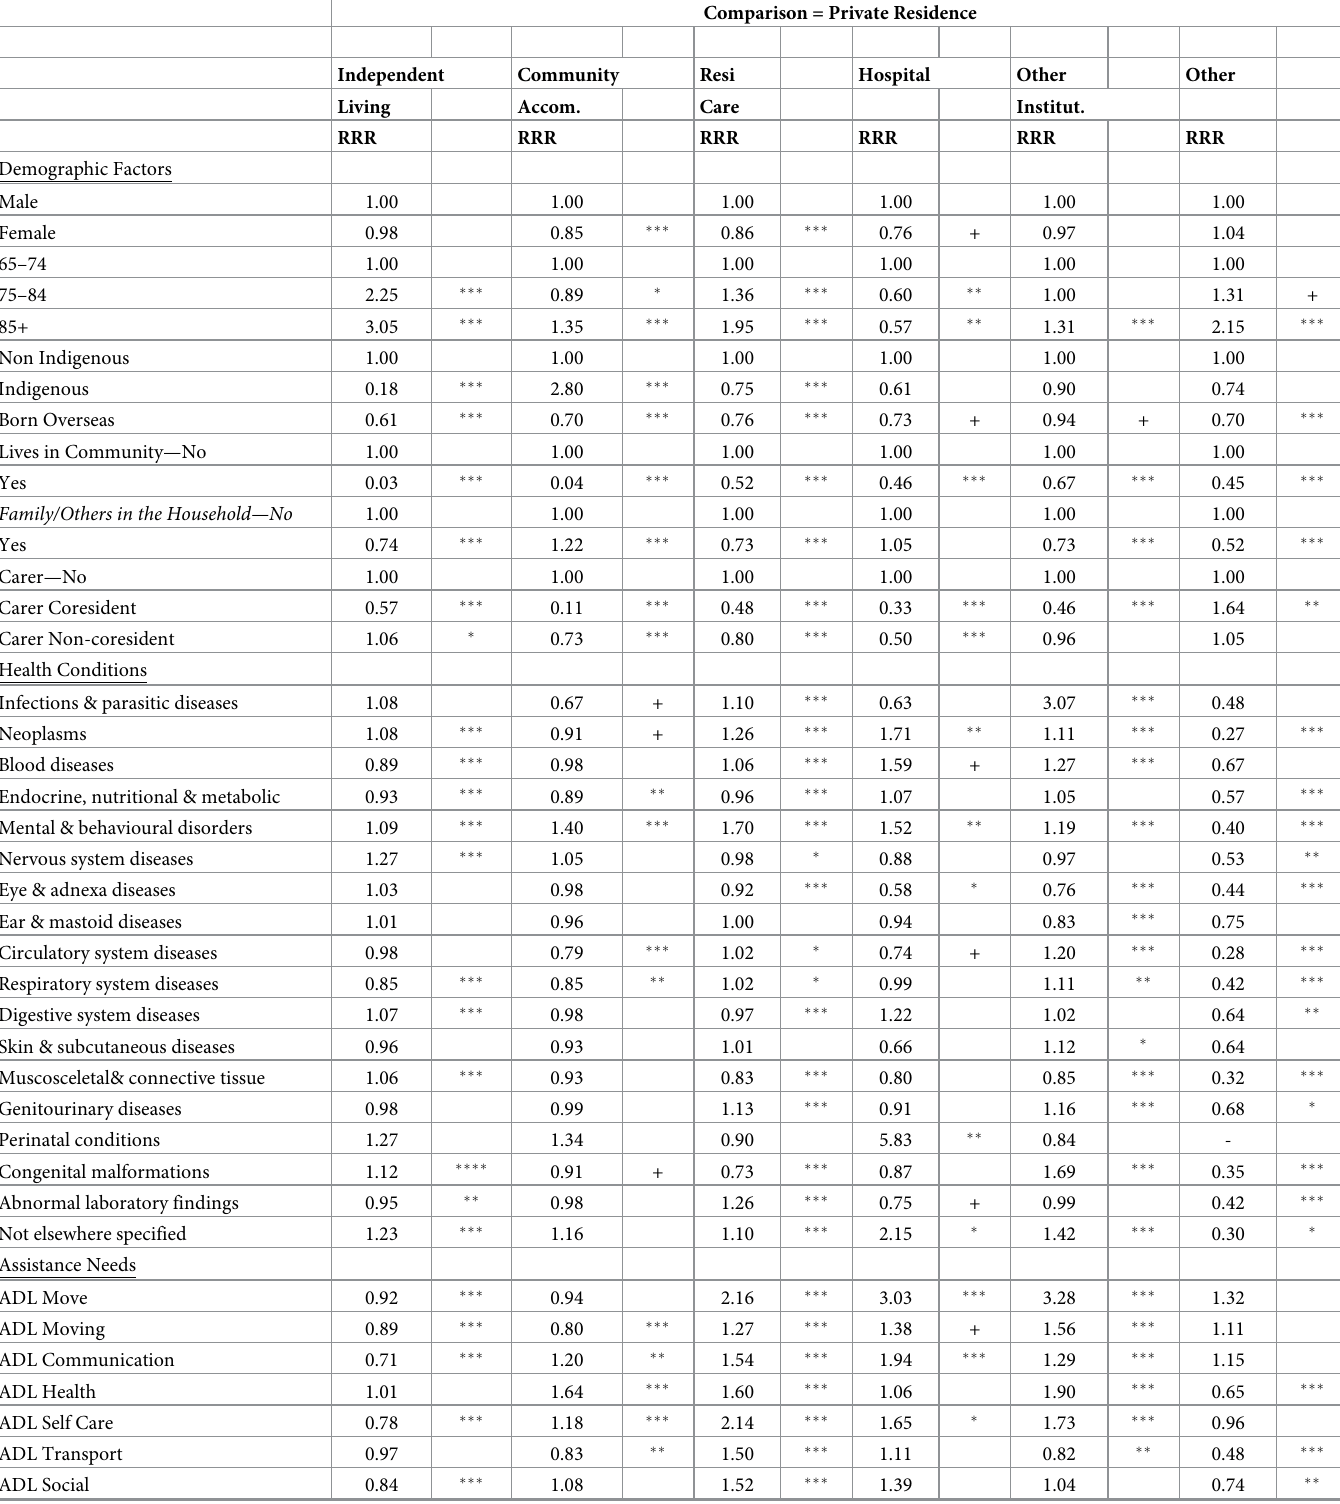
Table 5. MNL regression model of recommended long term care